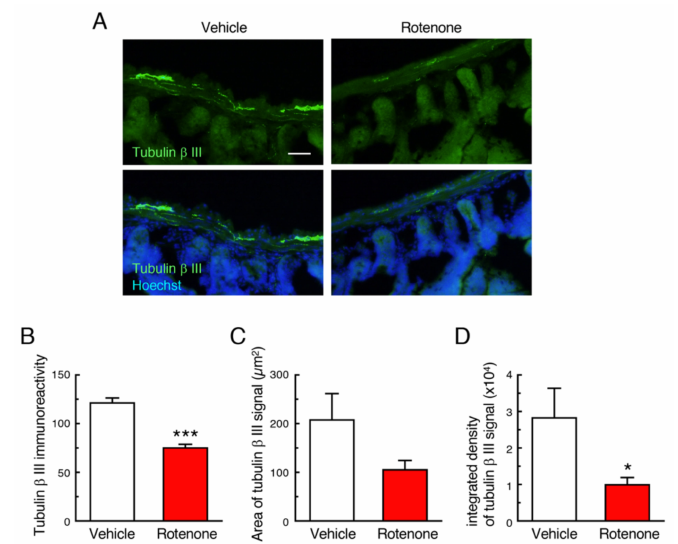
Figure 4. Chronic exposure to low-dose rotenone induced neurodegeneration in the intestinal myenteric plexus in mice. ( A ) Representative photomicrographs of immunohistochemistry for Tubulin β III in the intestine of mice. Green: Tubulin β III-positive neurons. Blue: nuclear staining with Hoechst 33342. Scale bar = 50 µ m. ( B – D ) Quantitation of Tubulin β III-positive signals in the intestine. ( B ) Signal intensity of Tubulin β III immunoreactivity in the myenteric plexus. ( C ) Area of Tubulin β III-positive myenteric plexus, ( D ) Integrated density of Tubulin β III immunoreactivity. Each value is the mean ± SEM ( n = 4). * p < 0.05, *** p < 0.001 vs. the vehicle-treated control group (two-tailed unpaired independent t-test).